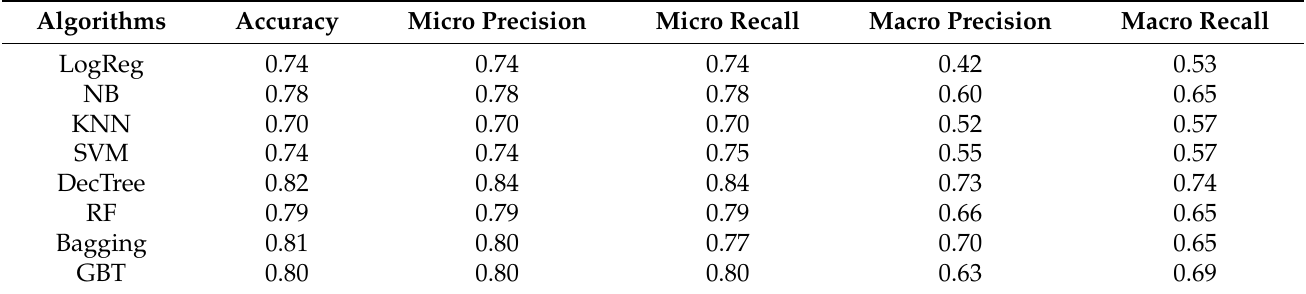
Table 4. Comparison of evaluation metrics for classification algorithm on multiclass classification.